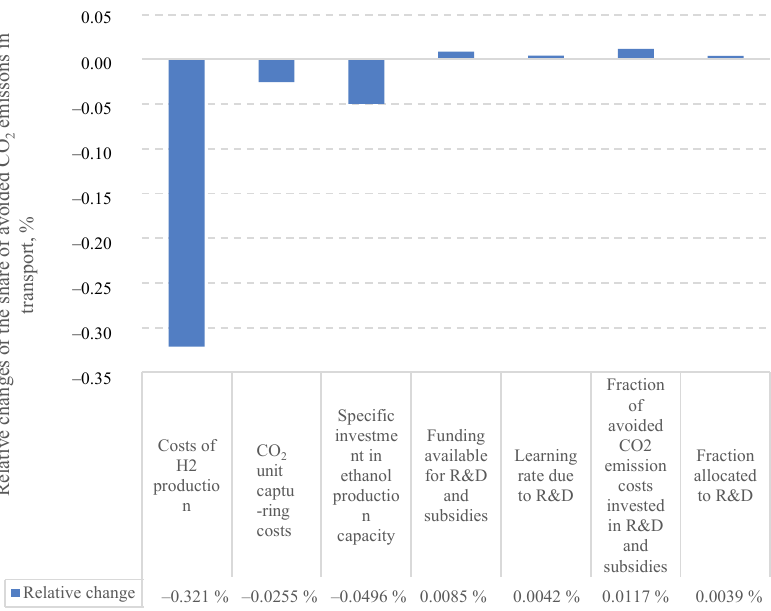
Fig. 8. Results of sensitivity analysis. Blue bars represent relative changes (increase or decrease) of the share of avoided CO 2 emissions in transport if the factors shown in the graph increase by 1 %. The share of avoided CO 2 emissions in transport reaches 0.12 by the year 2050 in the reference scenario (see Fig.